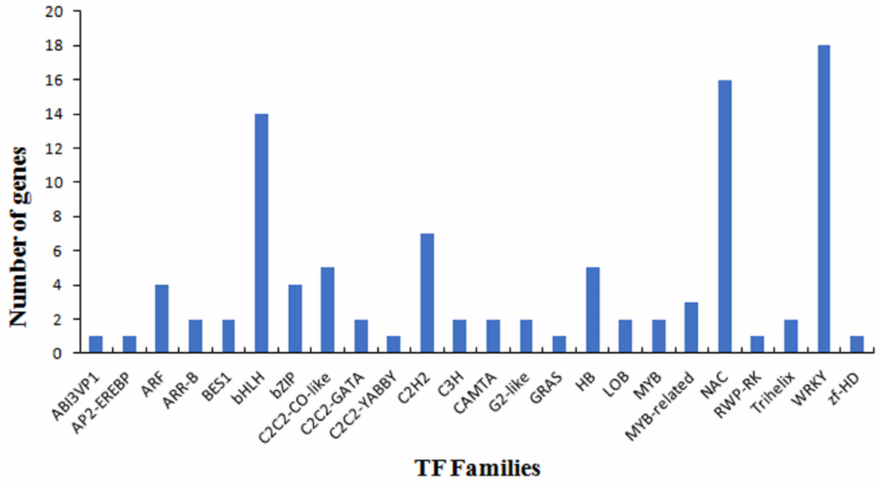
Figure 2. Transcription factors (TF ) families’ distribution of differentially expressed genes (DEGs).